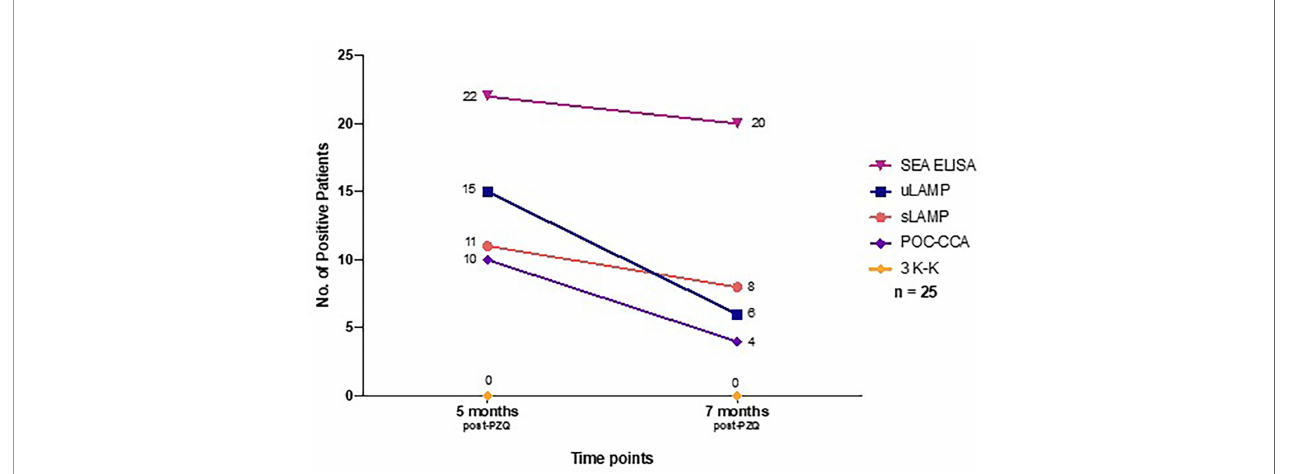
FIGURE 4 | Number of positive patients at 5 months and 7 months post-PZQ treatment based on different diagnostic tests (n = 25). PZQ, Praziquantel; SEA IgG ELISA, Soluble Egg Antigen; uLAMP, Urine LAMP; sLAMP, Serum LAMP; POC-CCA, Point-of-care circulating cathodic antigen urine test; 3 K-K, Three consecutive days stool